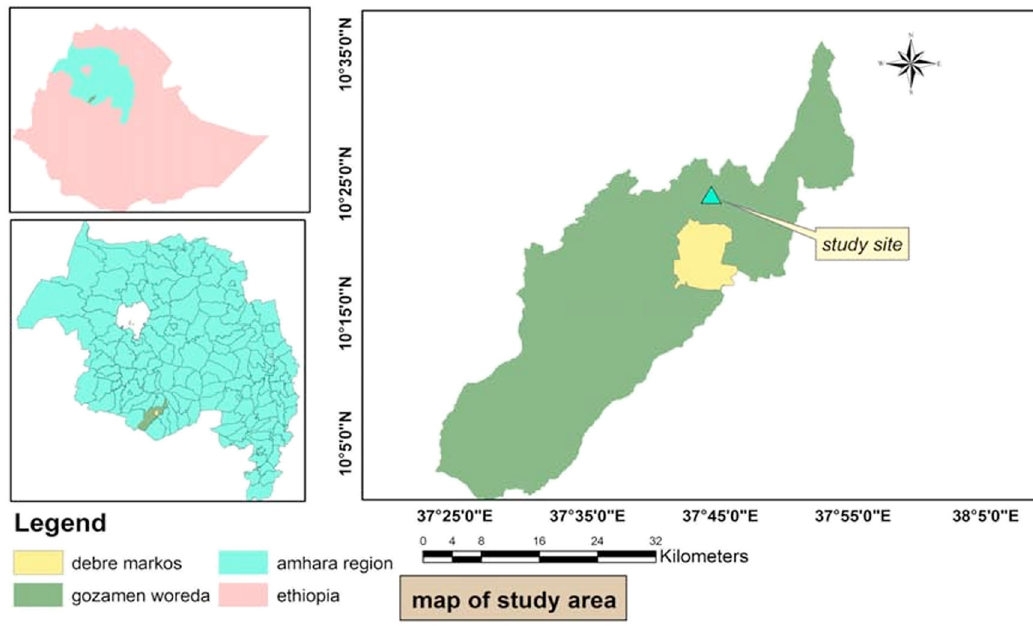
Figure 1: Location map of the study sites in Enerata, East Gojjam Zone, northwest